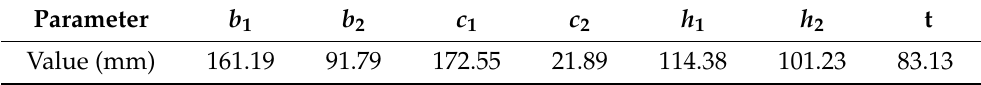
Table 4. Clavicle, Shoulder and Arm CAD mechanical design parameters.